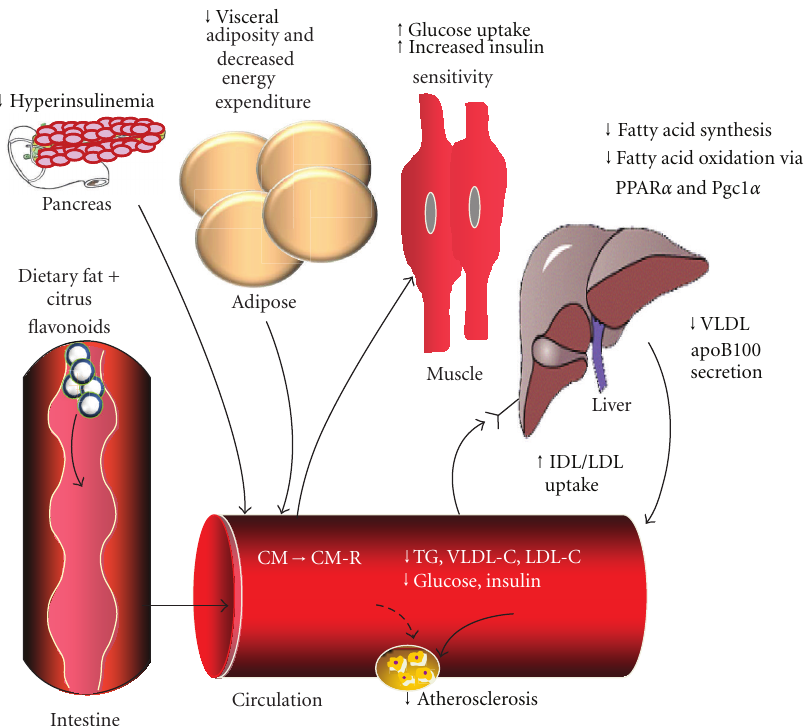
Figure 2: Potential mechanisms for the reduction in risk factors for atherosclerosis by flavonoids. Both in vitro and in vivo data suggest that citrus flavonoids decrease macrophage uptake of oxidized LDL and macrophage CE accumulation and improve dyslipidemia. While the complete mechanisms have not been fully defined, the nuclear hormone receptors PPAR α and PGC1 α represent important molecular targets. The improvement in dyslipidemia can be linked to decreased VLDL secretion as hepatic lipid availability for storage or VLDL secretion is decreased as a consequence of PPAR-stimulated fatty acid oxidation. The oxidation of fatty acids by liver prevents ectopic lipid accumulation and improves both insulin sensitivity and glucose tolerance. Arrows indicate change in response to flavonoid